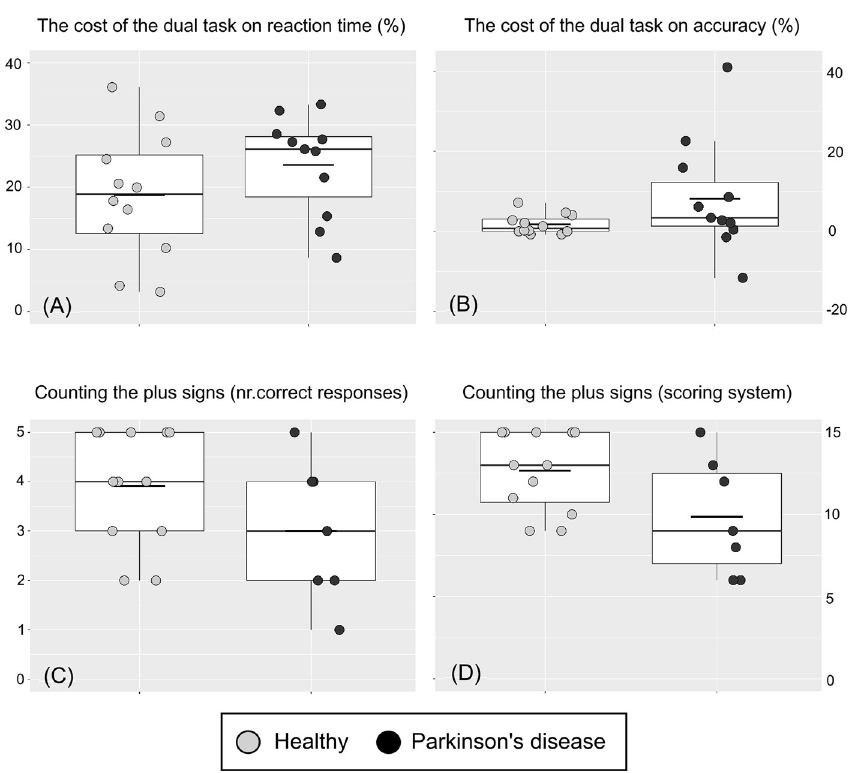
Fig 4. Outcomes of the dual task with performance on the group and individual level. (A) and (B): A score higher than zero indicates a cost of the dual task for that individual/group and outcome. (C): Performance on the counting task with one point given for each correct answer with a maximum value of 5. (D): Performance on the counting task by a scoring system (3 points for the correct answer, 1 point for the answer closest to the correct answer and 0 points for other answers) with a maximum value of 15. Each boxplot shows the median (the thin line), the mean (the short bold line), the 25th and 75th percentiles (the hinges) and the range from the smallest to the largest value if not exceeding 1.5 times the interquartile range (the